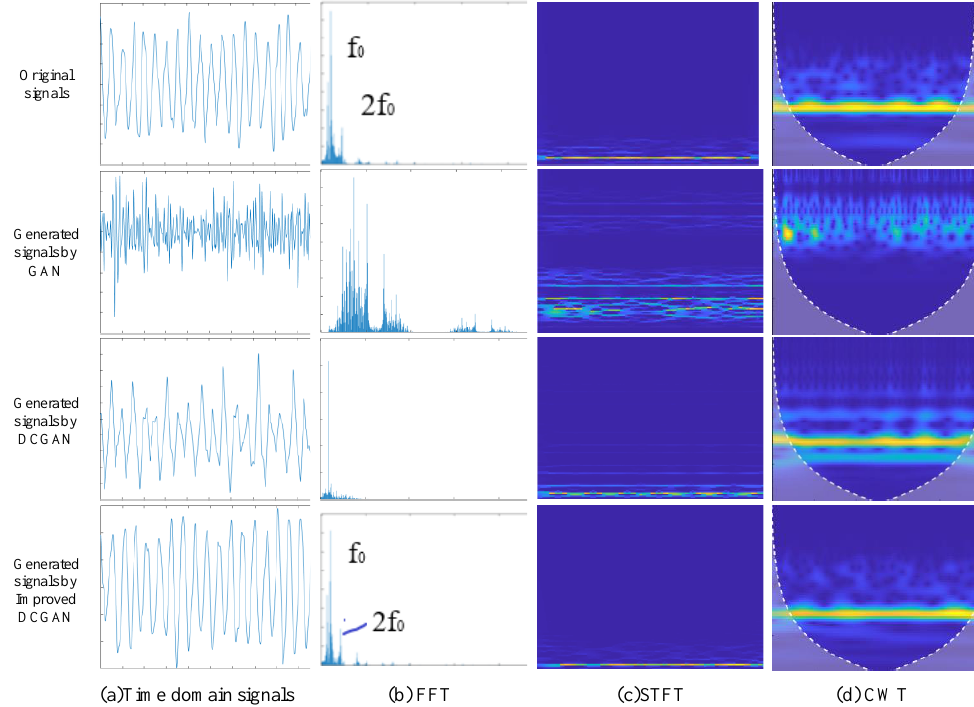
Figure 15. Signal comparison of time domain and frequency domain of the original signals and the generated signals in airflow excitation state.